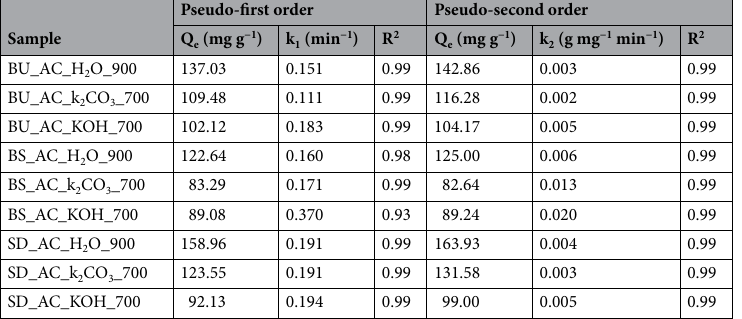
Table 4. Various kinetics parameters for the adsorption of phenol over as-prepared porous carbon materials under the optimized conditions of phenol dose of 100 mg L −1 , temperature of 25 °C, and pH of 4.